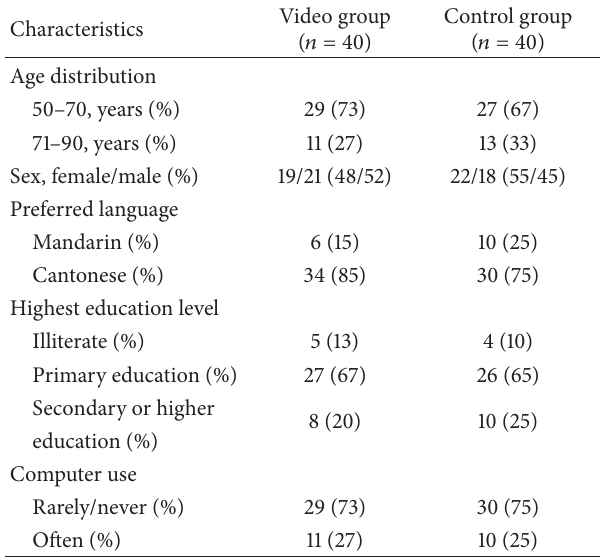
Table 1: Baseline characteristics of patients randomly selected for each